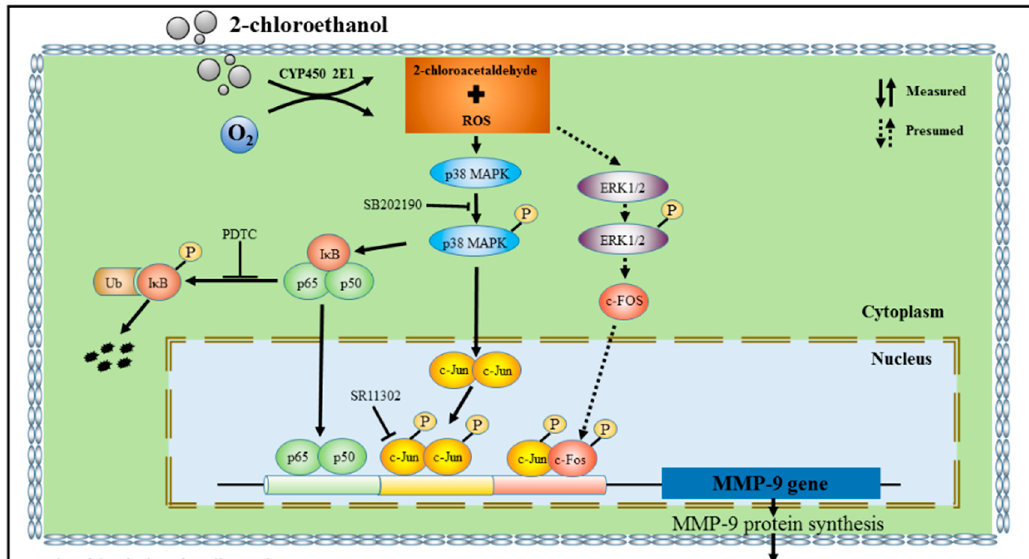
Figure 9. Schematic diagram. Figure 9 . Schematic diagram. Figure S1: Alteration in expression and phosphorylation of p38 MAPK in 2-CE exposed rat astrocytes along with the exposure time and 2-CE